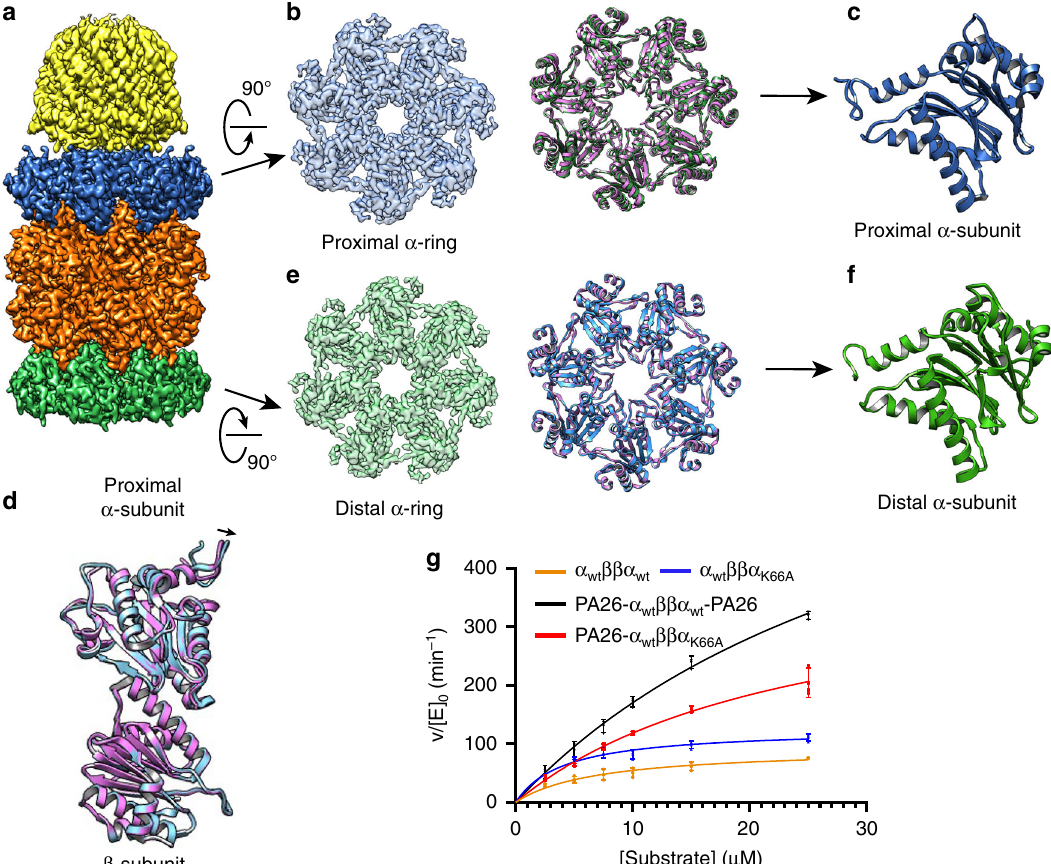
Fig. 5 Single-particle cryo-EM structure of PA26- α WT ββα K66A complex without substrate. a Cryo-EM reconstruction of PA26- α WT ββα K66A at a resolution of 3.5 Å. b , e Proximal and distal α -ring of the 20S CP. c , f Ribbon diagram of α -subunits from proximal and distal α -rings. Note that the N-terminus of proximal α -subunit points upwards, consistent with an open gate conformation. In contrast, the N-terminus of distal α -subunit points downwards, consistent with a closed gate conformation. d Ribbon diagram of an α -subunit from the proximal α -ring and its interacting β -subunit (gray) overlayed with the ribbon diagram of α / β -subunits from a 20S CP without activator bound (purple). Note that both α - and β -subunits are well-aligned between the two. g Kinetics of LFP degradation by symmetric (blue) and asymmetric (yellow) 20S CP alone and with double (black) and single (red) activator PA26. Three ( n = 3) biologically independent experiments were carried out to derive the mean and standard deviation. The means are used to derive the curve and the error bars represent standard